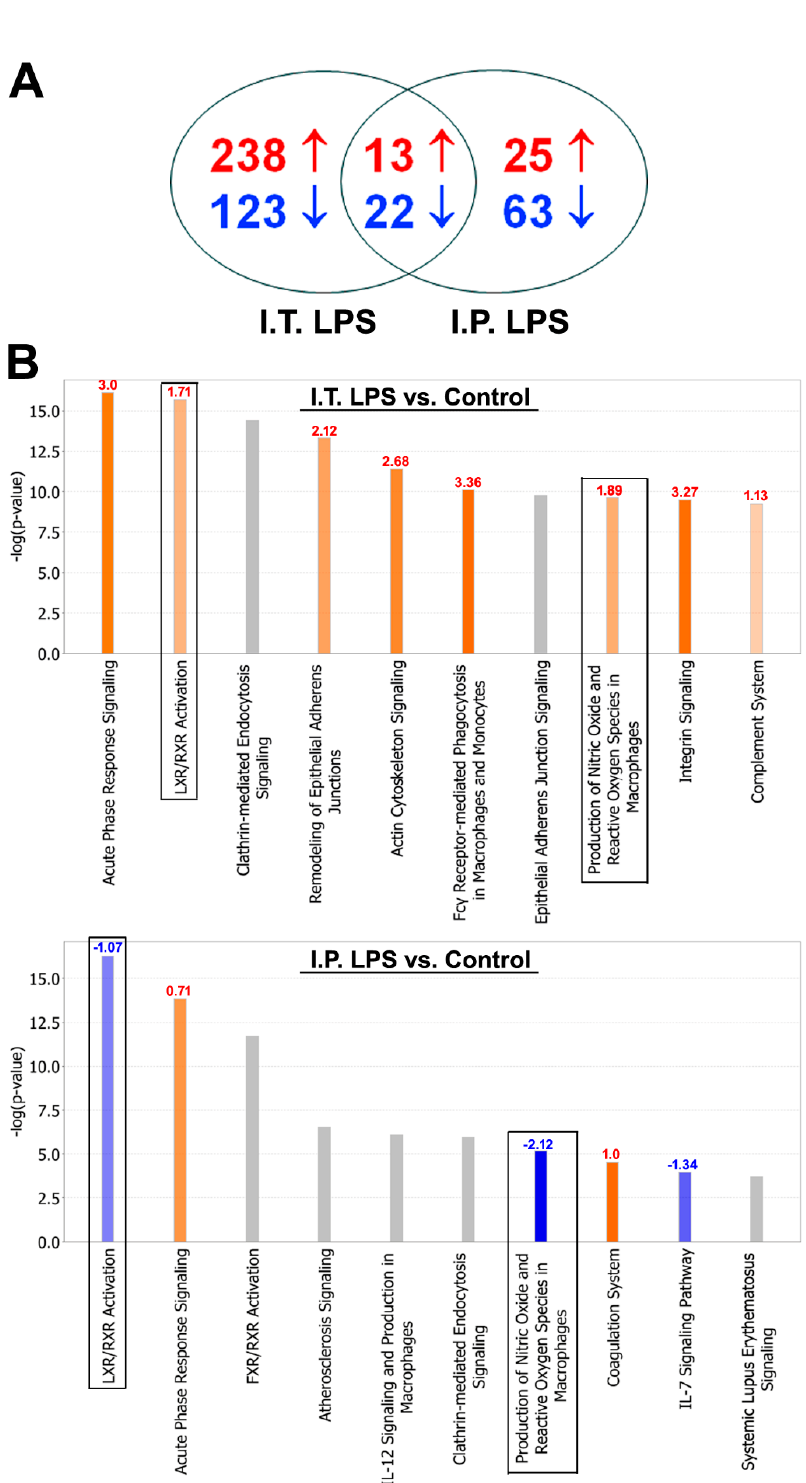
Figure 2. Proteomic profiling of BALF from mice treated with I.T. and I.P. LPS compared to the controls. ( A ) Number of up- and down-regulated proteins in BALF following I.T. ( n = 4) and I.P. ( n = 3) LPS treatment compared to the controls ( n = 3); ( B ) Top-10 enriched canonical signaling pathways identified by Ingenuity Pathway Analysis. Orange, activated; blue, inhibited; grey, no activity pattern available. Z-score was placed on top of each bar. Positive z-score, activation; negative z-score, inhibition. Boxed pathways, di ff erentially regulated pathways between I.T. and I.P. LPS groups compared to the controls.